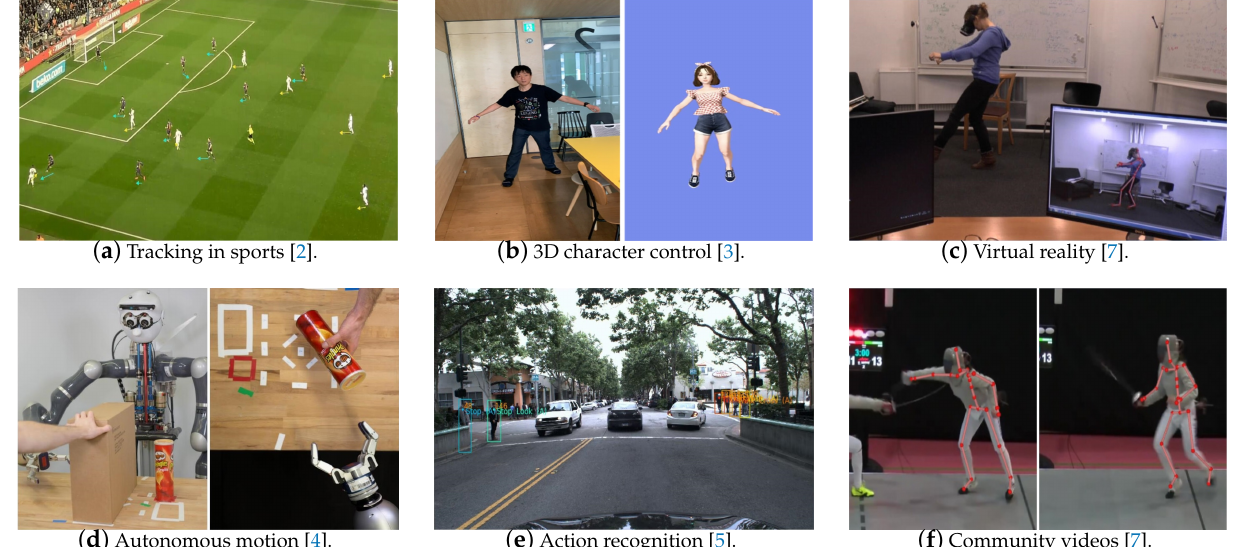
Figure 1. Some application related with 3D human estimation